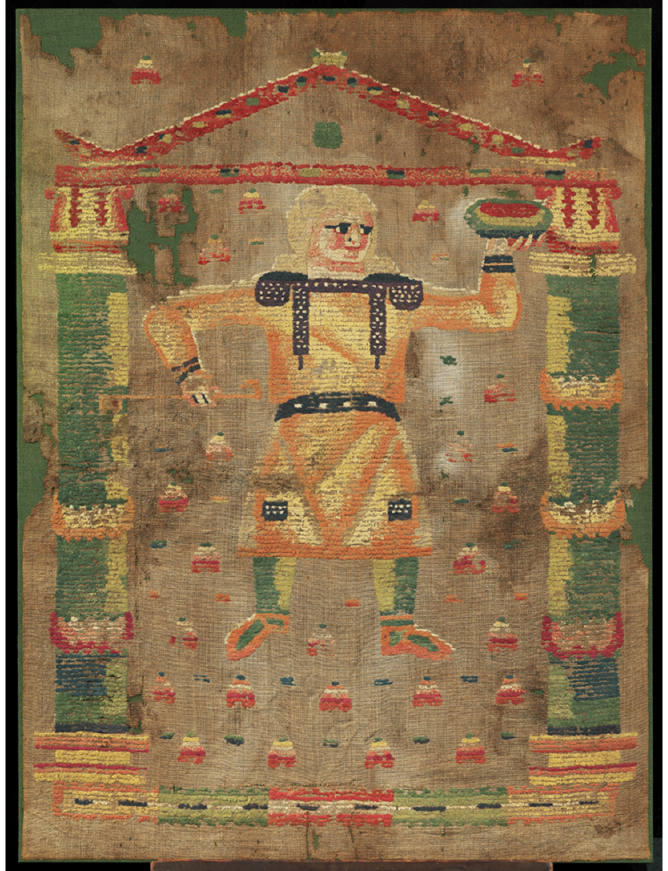
Figure 10. Fragment of a curtain , 4th–6th century CE. Late Roman. Linen plain weave with polychromy wool weft pile loops; 97.5 × 131 cm (38 3/8 × 51 9/16 in.). Museum of Fine Arts, Boston, Charles Potter Kling Fund, 49.313. Photograph © [2022] Museum of Fine Arts, Boston.